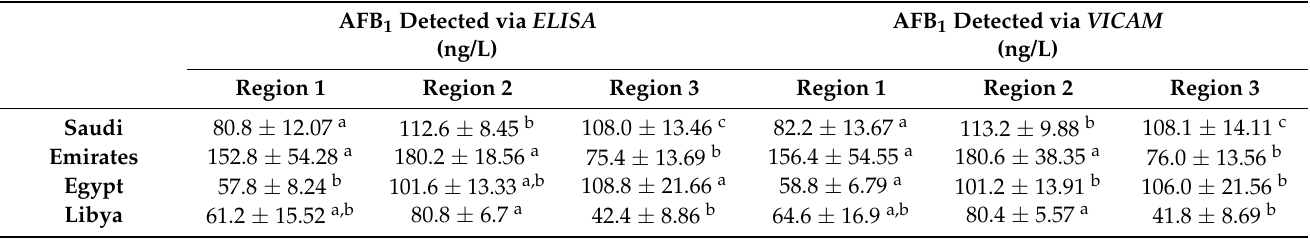
Table 2. Determination of aflatoxin B 1 in camel milk collected from two areas, the Arabian Peninsula and North Africa, evaluated via ELISA and VICAM techniques.